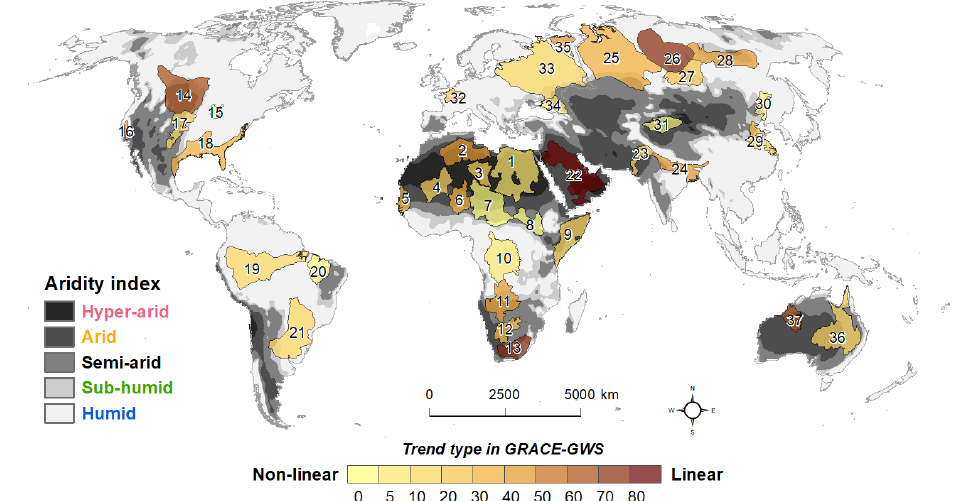
Figure 1. Global map of 37 large aquifer systems from the GIS database of the World-wide Hydrogeological Mapping and Assessment Programme (WHYMAP); the names of these aquifer systems are listed in Table 1 and correspond to the numbers shown on this map for reference. Grey shading shows the aridity index based on CGIAR’s database of the Global Potential Evapotranspiration (Global-PET) and Global Aridity Index (https://cgiarcsi.community/, last access: 5 August 2020); the proportion (as a percentage) of long-term trends in GRACE-derived (cid:49) GWS of these large aquifer systems that is explained by linear trend fitting is shown in colour (i.e. linear trends toward dark red and non-linear trends toward light